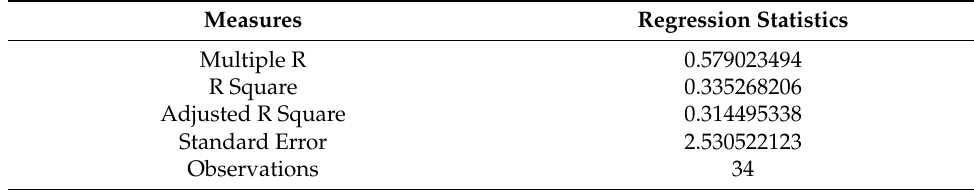
Table 6. Regression analyses.